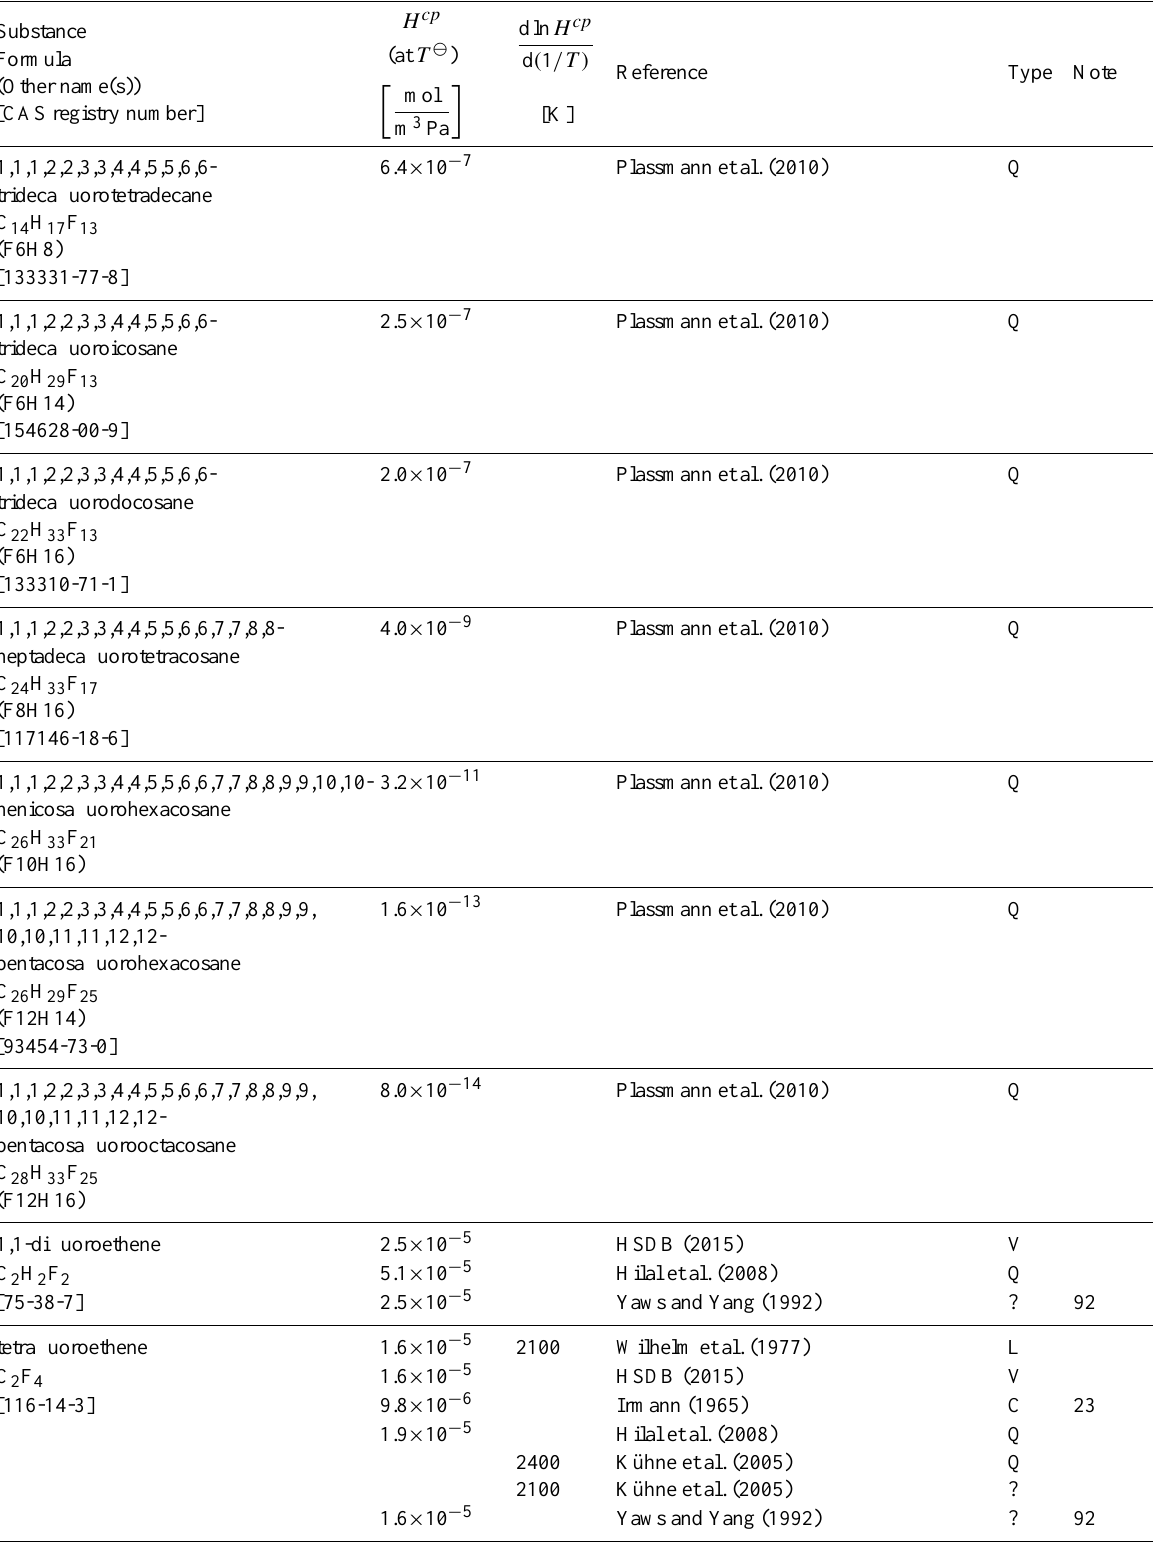
Table 6: Henry’s law constants for water as solvent